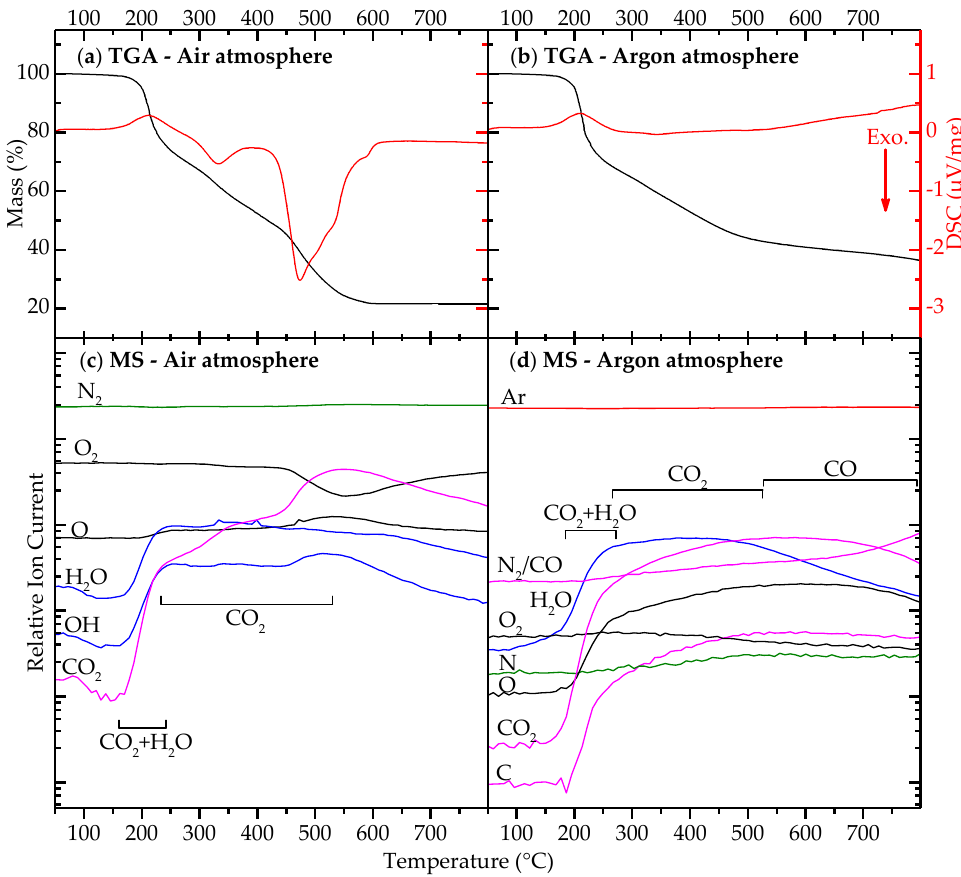
Figure 4. Thermogravimetric analysis (TGA) of dried BNT gel: ( a , b ) mass loss (black, left axis) and differential scanning calorimetry (red, right axis); and ( c , d ) in situ mass spectroscopy (MS) of TGA outlet gas. Different graphs correspond to specific m / z values, labeled with the gaseous species contributing to the m / z current. Lines are color coded: green, nitrogen; black, oxygen; blue, water; magenta, carbon; and red, argon. Dominating gaseous species for mass loss are indicated next to MS-curves. In ( d ), combined assessment of curves for N, C and CO 2 shows that N 2 /CO signal originates from N 2 at low temperature and CO at high. Ramp up rate: 10 °C/min.